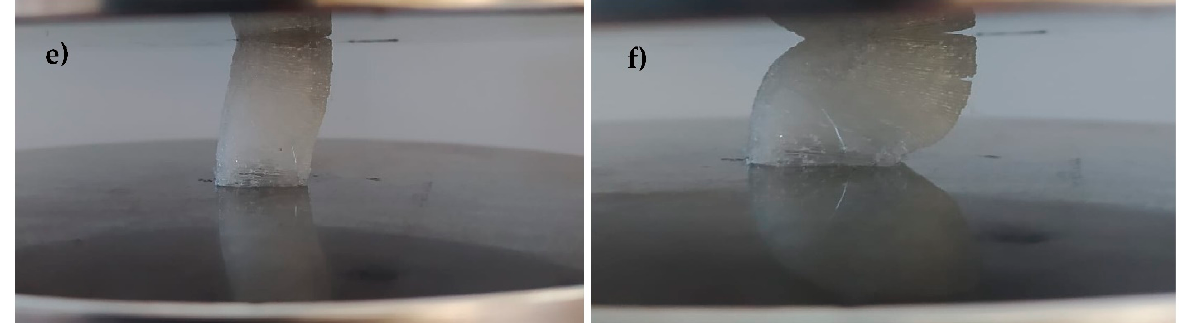
Figure 4. Details of the specimens during the compressive tests for ( a ) PETG+CF in the linear region; ( b ) PETG+CF at the beginning of the nonlinear region; ( c ) PETG+CF in the nonlinear region; ( d ) PETG+CF before the collapse; ( e ) PETG in the nonlinear region; ( f ) PETG before the collapse.